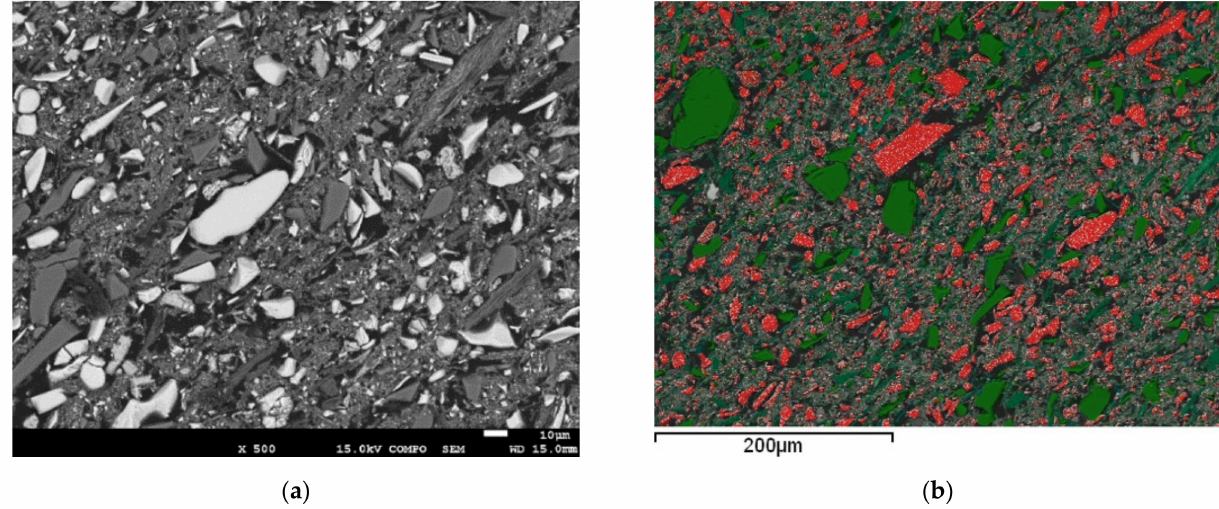
Figure 6. ( a ) Selected SEM image (500 × magnification); ( b ) X-ray elemental mapping image (500 × magnification).